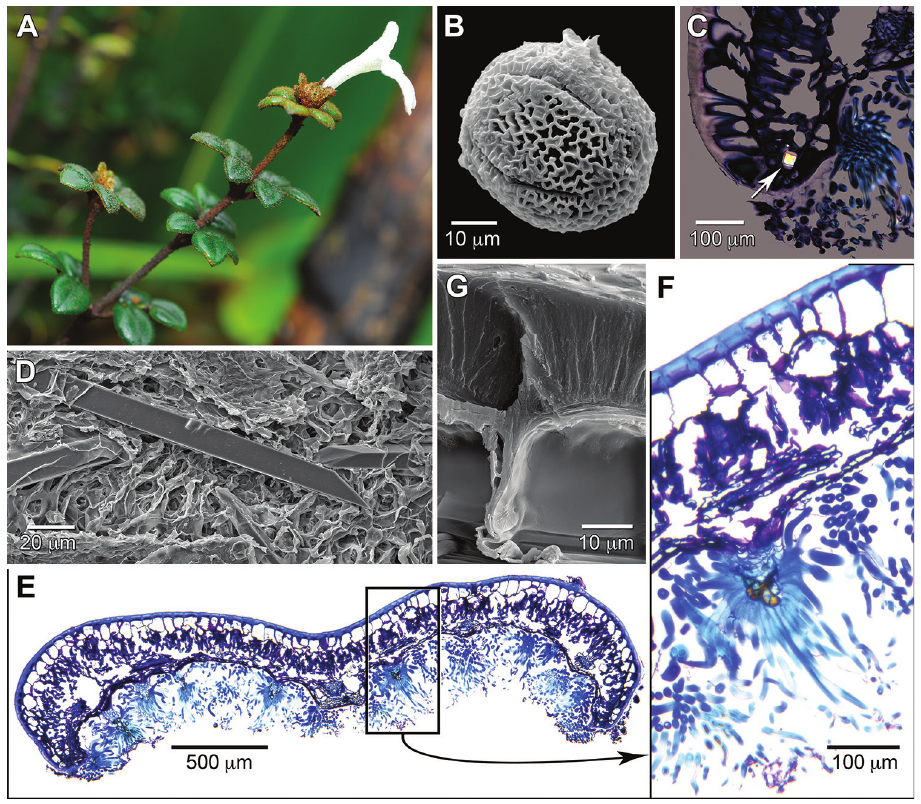
Figure 2. Morphology and anatomy of Raveniopsis microphyllus . A Life photo of flowering branch show- ing strongly zygomorphic, white corolla B Pollen with mesocolpium-centered equatorial view of whole grain C Transverse section of leaflet edge under polarized light, showing bright styloid crystal (at arrow) D In-situ styloid crystals near secondary vein E Transverse section of entire leaflet (tiled image) F Trans- verse section in closer view showing thick adaxial cuticle, and abaxial trichome with multicelled stalk G Adaxial epidermis showing thick cuticle above epidermal cells. (Source: Tripp 3191 ,